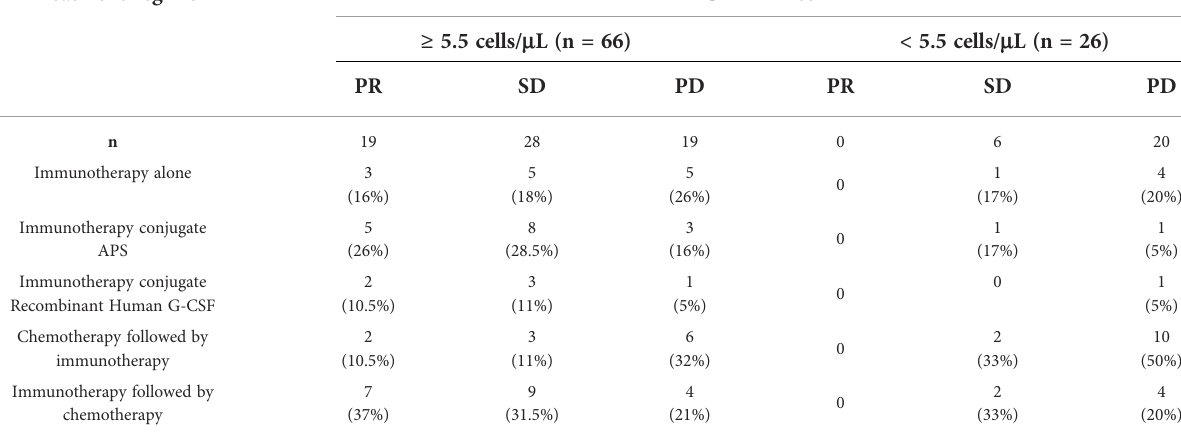
TABLE 7 Frequency for response of treatment options in the AC of CD4 + Tn cell in aNSCLCs. Treatment